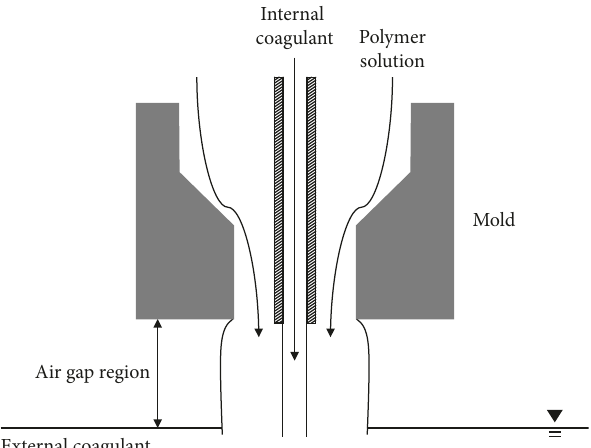
Figure 1: Schematic diagram of preparing hollow-fiber adsorbents by nonsolvent-induced phase